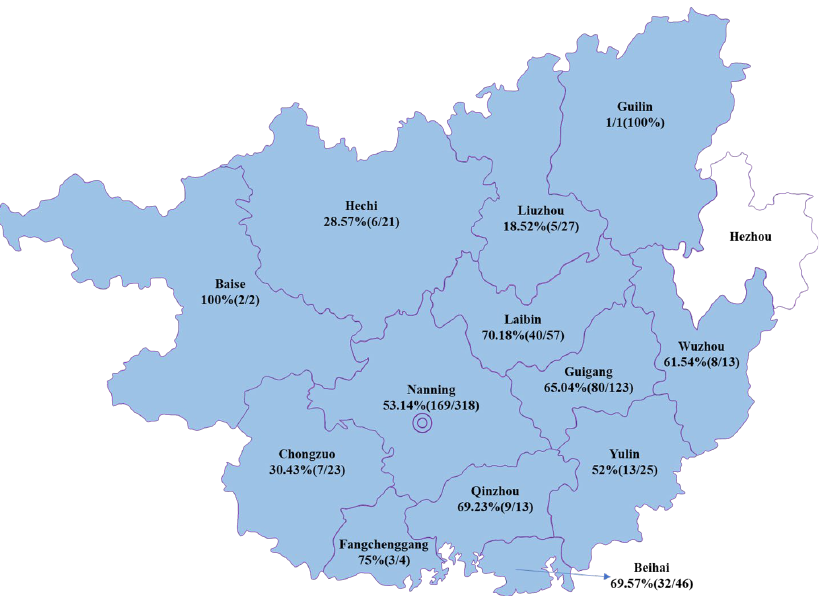
Figure 1. Map of PEDV distribution in pigs in 13 regions of Guangxi, China. The positive rates of PEDV infection are labeled for the regions. No clinical samples were collected from Hezhou.